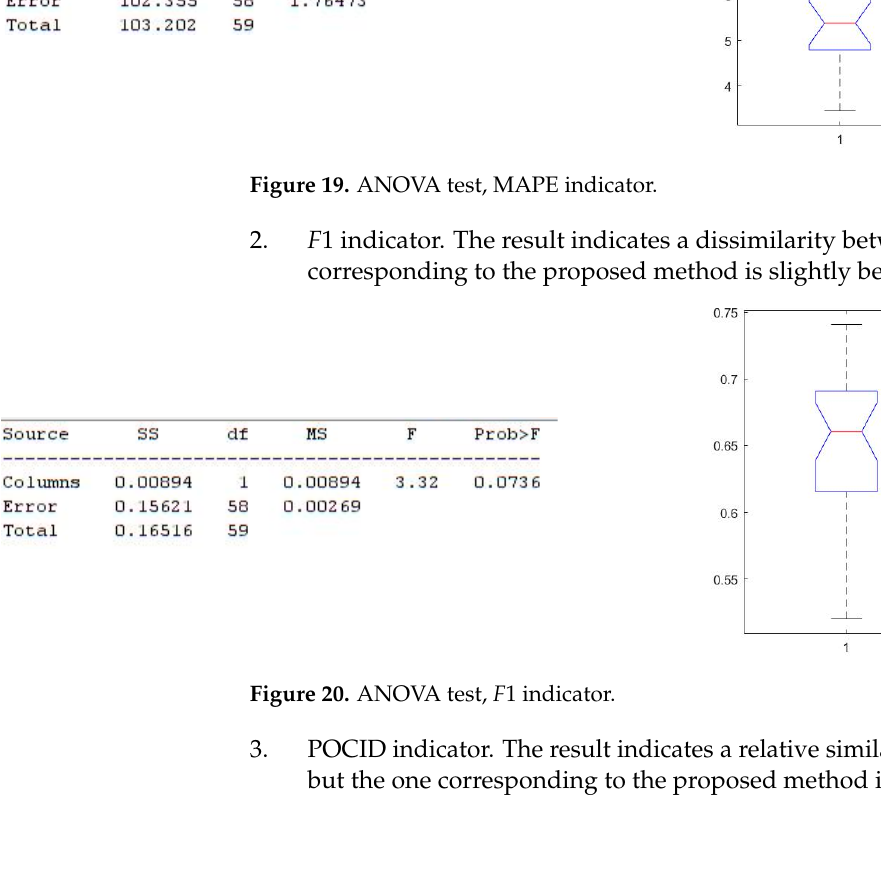
Figure 21. ANOVA test, POCID indicator. The results of training and testing the LSTM neural network to implement (25) using an ADAM optimizer are depicted in Figure 22. The actual values of ETH–USD time series versus the forecasted outcomes in the case of the proposed ES-LSTM algorithm are pre- sented in Figure 23. The parameters used by the ES-LSTM algorithm were: 𝑐𝑡 = 0.15 , 𝑁𝑀𝑎𝑥 = 11 , 𝑁𝐴𝑡𝑡 = 200 , 𝜎 = 0.01 , 𝜏 = 15 , ϑ = 0.9 and 𝜀 = 0.01 . The figures present the results of one of the 30 runs.